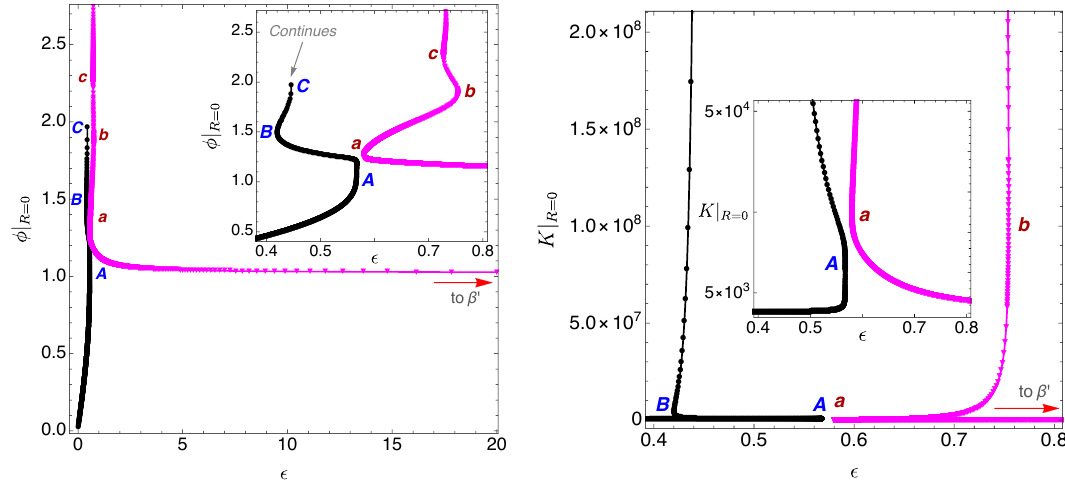
Figure 8 . Soliton families with e = 1 . 854 ( e γ < e < e c ) with the main (black disks) and secondary (magenta triangles) families. In both figures, the inset plots zooms in around the region where the two soliton families approach the most. As e → e − , the gap between A and a decreases until these c two points merge precisely at e = e c . Left panel: the core value of the scalar field is plotted as a function of (cid:15) . Right panel: the value of the Kretschmann at the origin is plotted as a function of (cid:15) . Both families have diverging Kretschmann as one moves along the damped oscillation